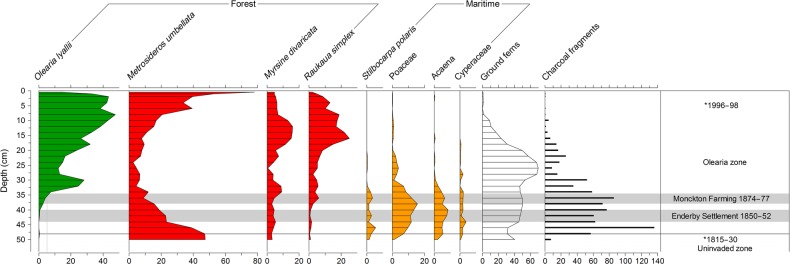
Summary percentage pollen record from the coastal Erebus Cove site (taken under an O. lyallii canopy), main Auckland Island. Grey bars show the time of the Enderby Settlement (1850–52) and Monckton Farming (1874–77) periods according to age-depth model. *Position and age of calibrated radiocarbon (cal year AD) dates from Table 1.